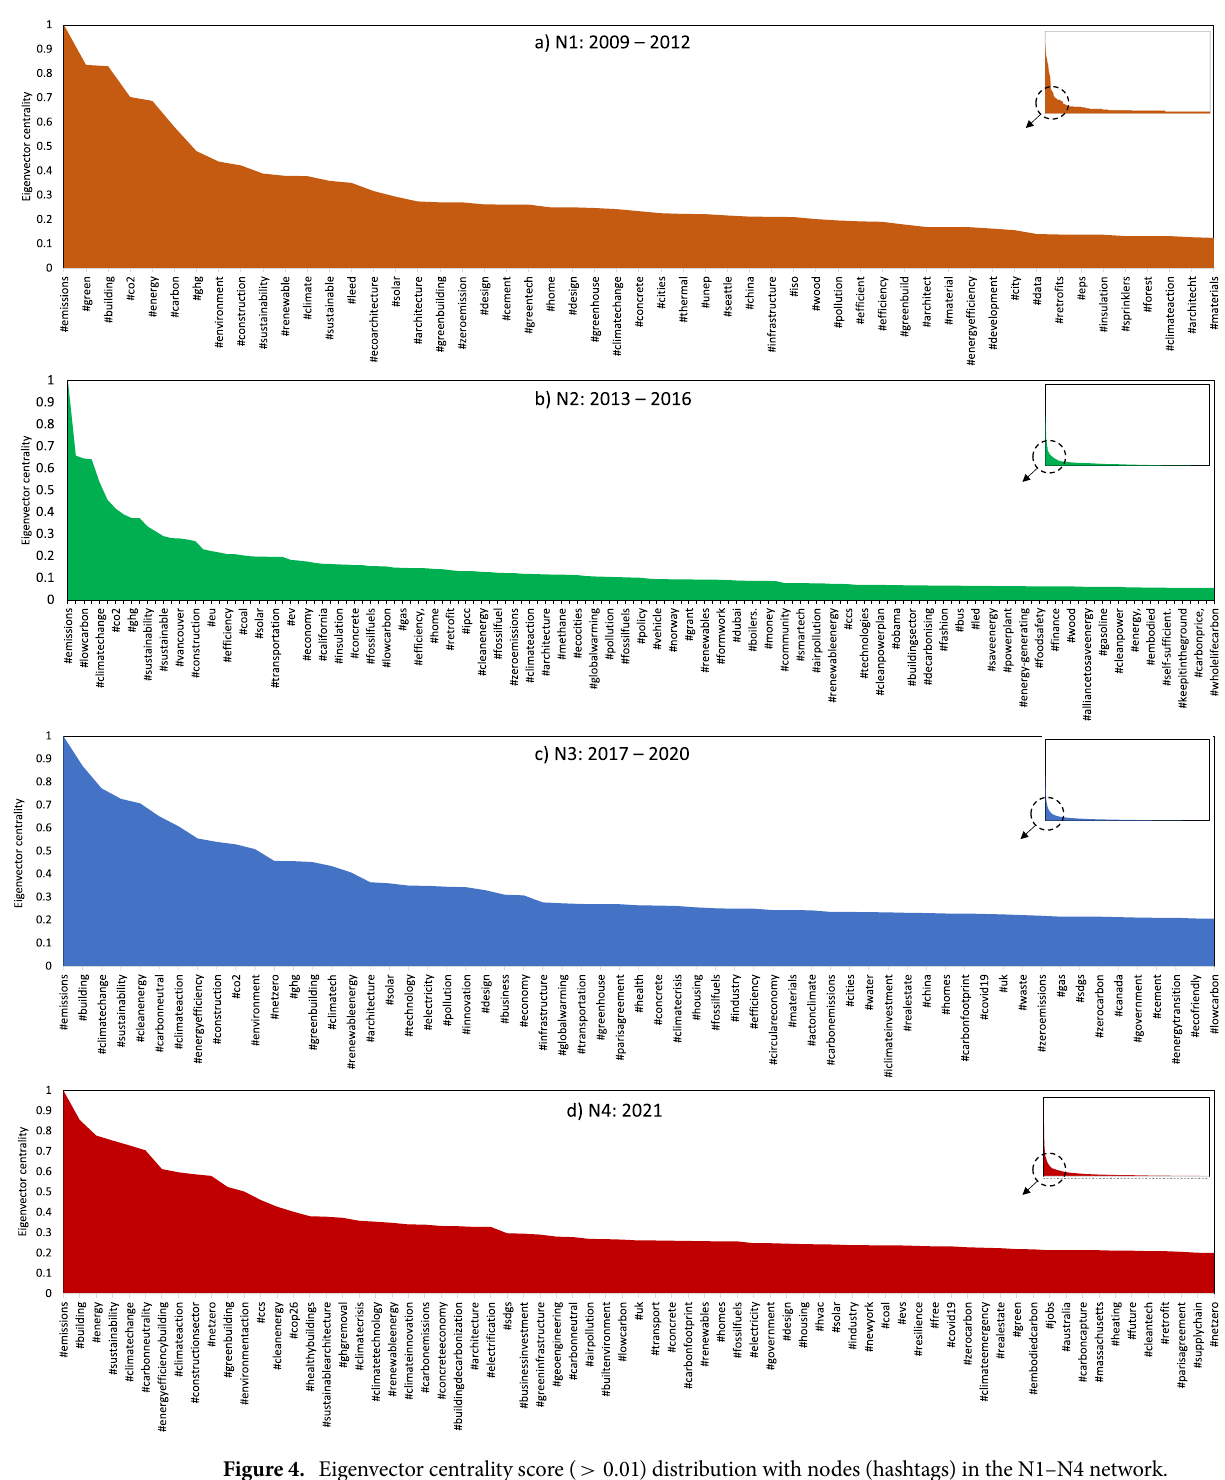
Figure 4. Eigenvector centrality score ( > 0.01 ) distribution with nodes (hashtags) in the N1–N4 network. A score of 1 indicates highest influence of a specific hashtag, while 0 implies hashtags of least influence. This measure demonstrates changing online public discourse through hashtags over the 13 year of climate policy action. We see mid-end of centrality scores (0.1– 0.3) to be most dynamic across the networks and use it as a basis for analysis in this paper. Extended results are presented in SI Figures A2, A3 and